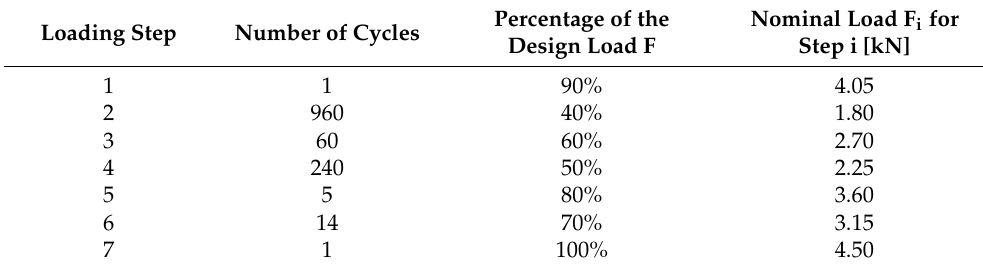
Table 4. Load history for cyclic